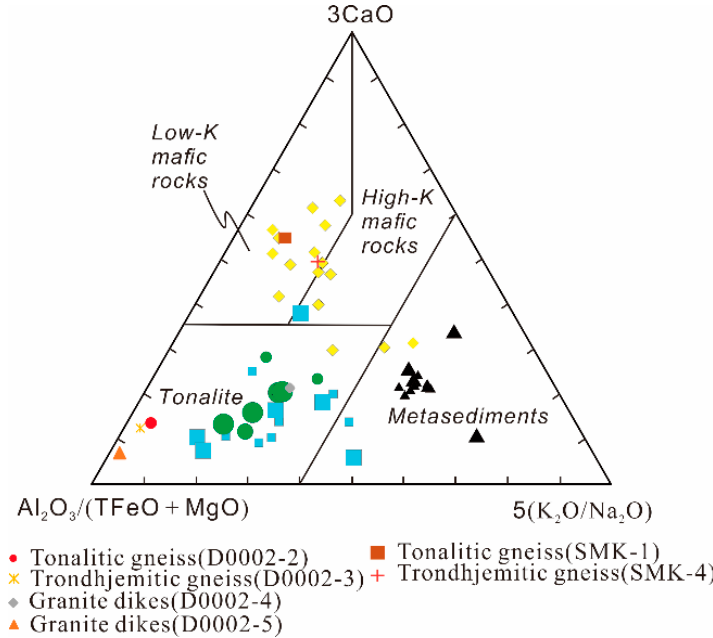
Figure 21. Ternary diagram of Al 2 O 3 / (TFeO + MgO) vs. 3CaO vs. 5(K 2 O / Na 2 O) (after Laurent et al. [62]). The different fields represent the compositions of melts derived from a range of potential sources (tonalites, metasediments, and low- and high-K mafic rocks), determined by the major-elementcompositionsofpartialmeltsinexperimentalstudies(seereferencesinLaurent et al. [62]). Symbols: diamonds = TTGs, circles = biotite granites, squares = two-mica granites, triangles = A-type granites. Data sources include this and previous studies